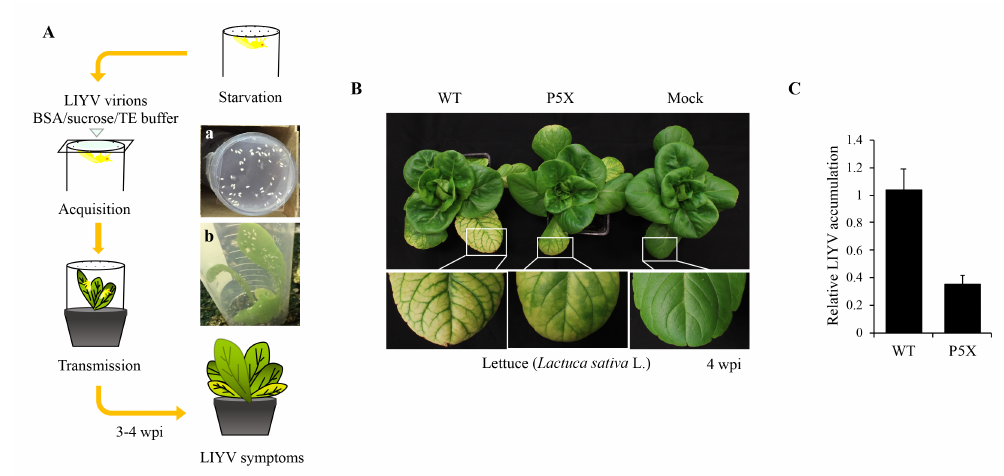
Figure 4. Mutational analysis of P5 function in LIYV infection of lettuce ( Lactuca sativa L.) plants. ( A ) Schematic representation of LIYV virions purified from systemically infected Nicotiana